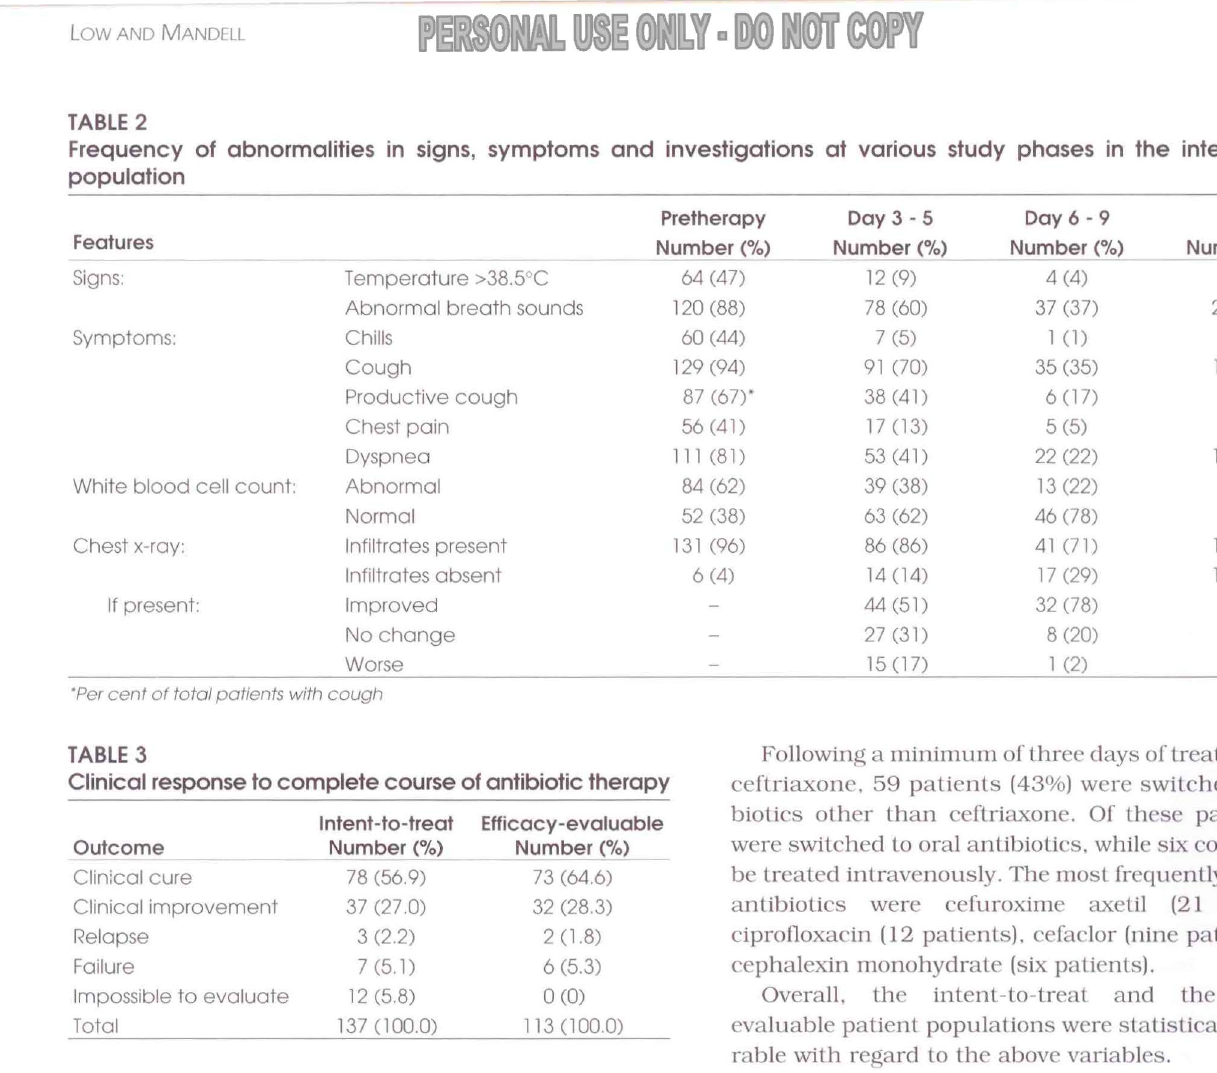
evaluable patient populations were statistically compa rable with regard lo the above variables. The clinical efficacy assessments are presented in Table 3. Based on the inlenl-to-lrcal analysis ap proach, 57% of lhe patients were clinically cured and 27% showed clinical in1provemenl. Relapse of infection was noted in U1ree patients, while seven patients failed to respond lo therapy. Clinical outcome could nol be evaluated in 12 patients. In the efficacy-evaluable population, favourable treatment outcome (clinical cure and improvement com